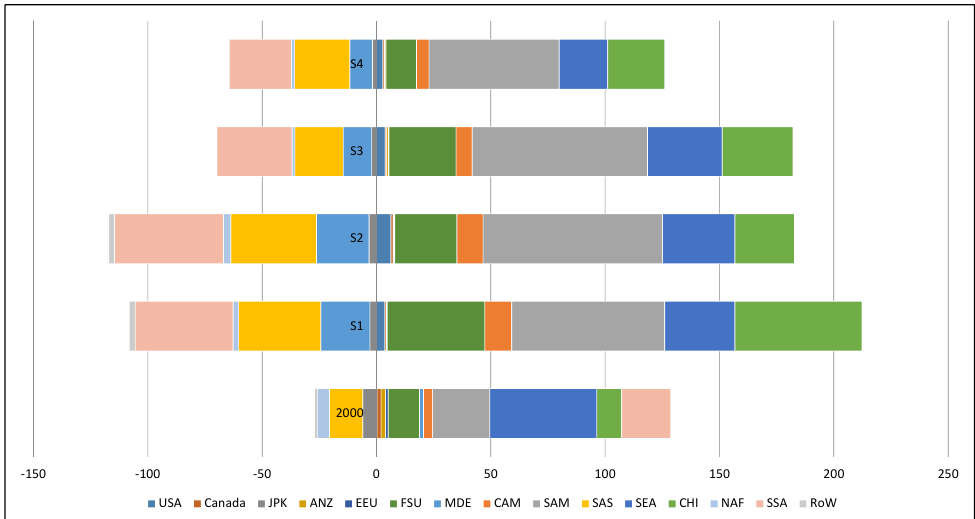
Figure 4. Net virtual water import by Western Europe (WEU) (billion m 3 /year), specified by world region. Positive values represent net virtual water import to WEU from other regions; negative values represent net virtual water export from WEU to other regions.